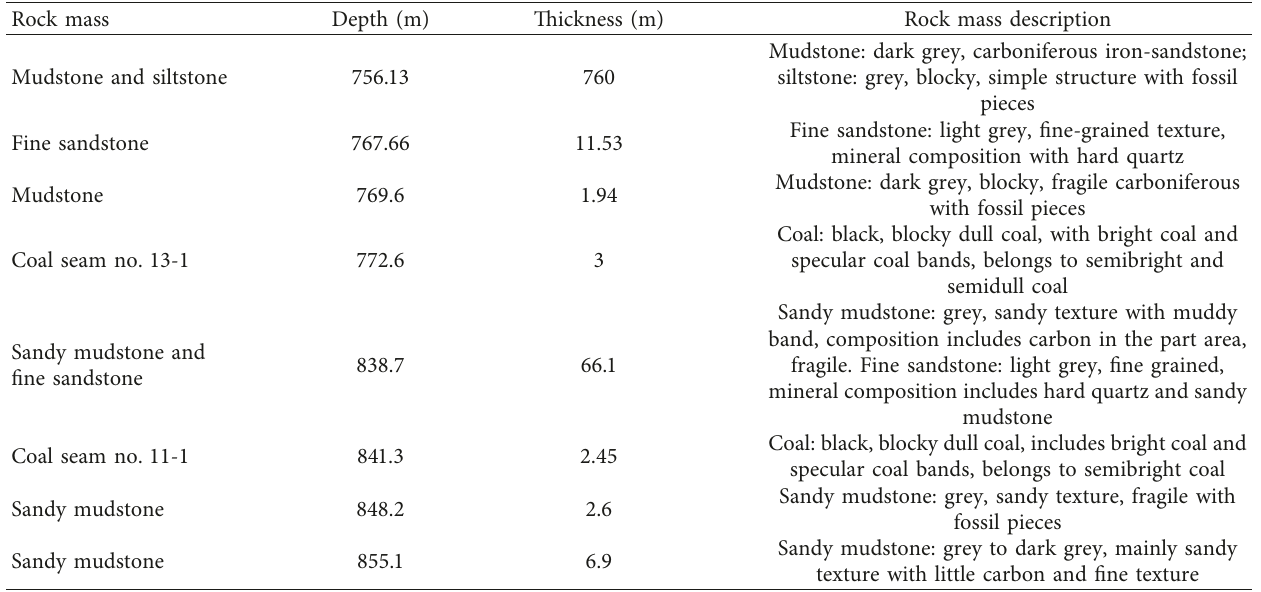
Table 3: Lithology of Case